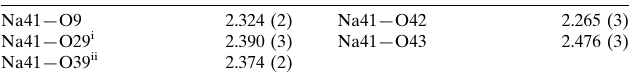
Selected bond lengths (A˚ ).